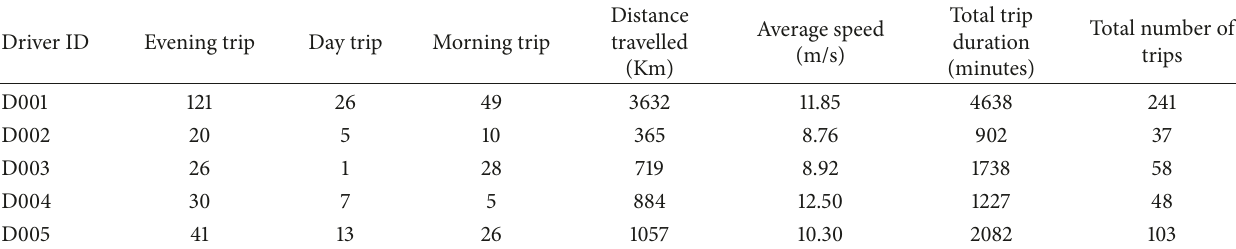
Table 1: Basic statistics and travelled distance for a representative sample of